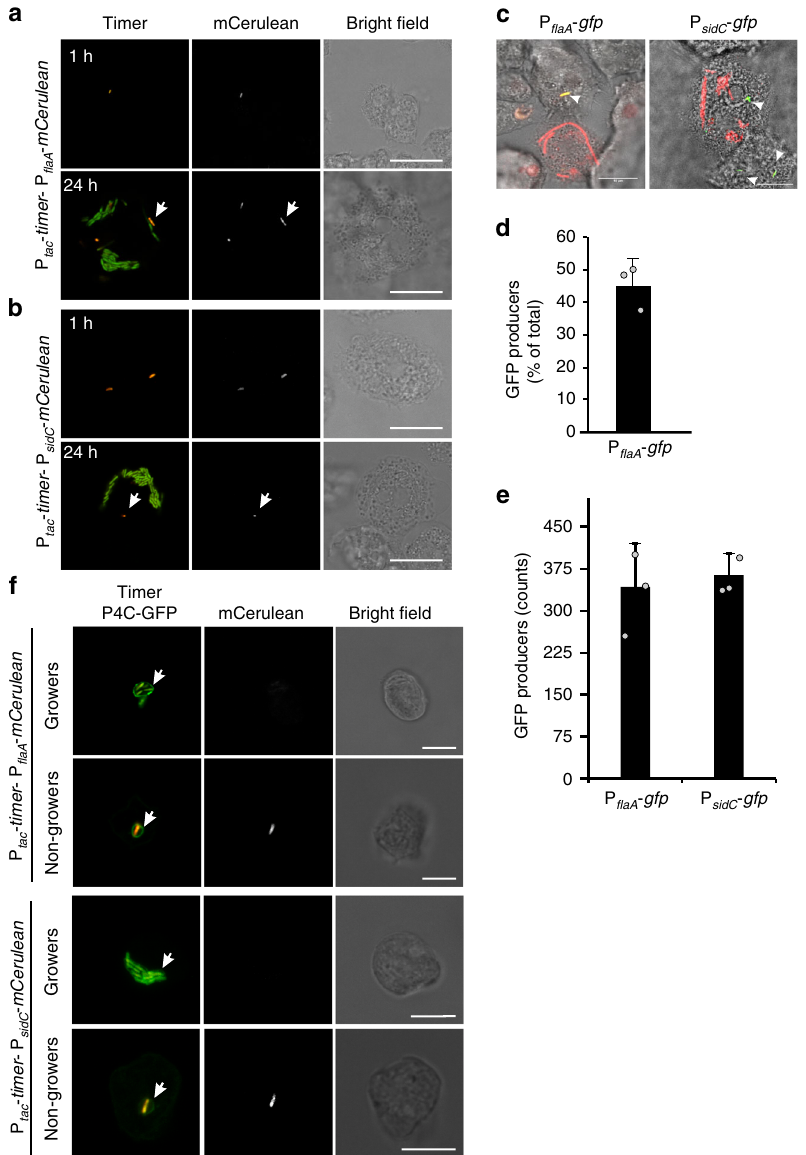
Fig. 5 Intravacuolar nongrowers express hallmark genes of motility and virulence. A. castellanii was infected (MOI 1, 5 h or 24 h) with L. pneumophila harboring the fl uorescent reporters a P tac - timer − P fl aA - mCerulean or b P tac - timer − P sidC - mCerulean , fi xed and analyzed by confocal microscopy. Micrographs show the fl uorescence for Timer at 500 and 600 nm, for mCerulean at 479 nm and the bright fi eld. The white arrows indicate intracellular red/orange nonreplicating and mCerulean-producing, transmissive bacteria. Scale bar 20 μ m. c A. castellanii was infected (MOI 1, 24 h) with L. pneumophila harboring the fl uorescent reporters P fl aA -gfp or P sidC -gfp , fi xed and analyzed by confocal microscopy. Micrographs show the overlay of bright fi eld and fl uorescence for P fl aA -gfp (500 nm, GFP; 600nm, mCherry, all bacteria) and for P sidC -gfp (500 nm, GFP; 405 nm, DAPI (false red color), all bacteria). The white arrows indicate intracellular nonreplicating and GFP-producing bacteria. Scale bar 10 μ m. d The subpopulation fraction and e the absolute number of intracellular GFP producers in the infected cell lysates were determined by fl ow cytometry. f D. discoideum amoebae producing the LCV marker and PtdIns(4) P probe P4C-GFP were infected (MOI 1, 24 h) with L. pneumophila (P tac - timer − P fl aA/sidC - mCerulean ), fi xed and analyzed by confocal microscopy. Micrographs show overlays of the fl uorescence at both 500 and 600 nm (to detect Timer and P4C-GFP) and 479 nm (mCerulean). White arrows show GFP-positive membrane surrounding both intracellular growers and nongrowers. Only the nongrowers express hallmark genes for motility and virulence. Scale bars 20 μ m. Data represent the mean ± SEM of three biological replicates ( n = 3; light gray fi lled circles). Source data are provided as a Source Data fi